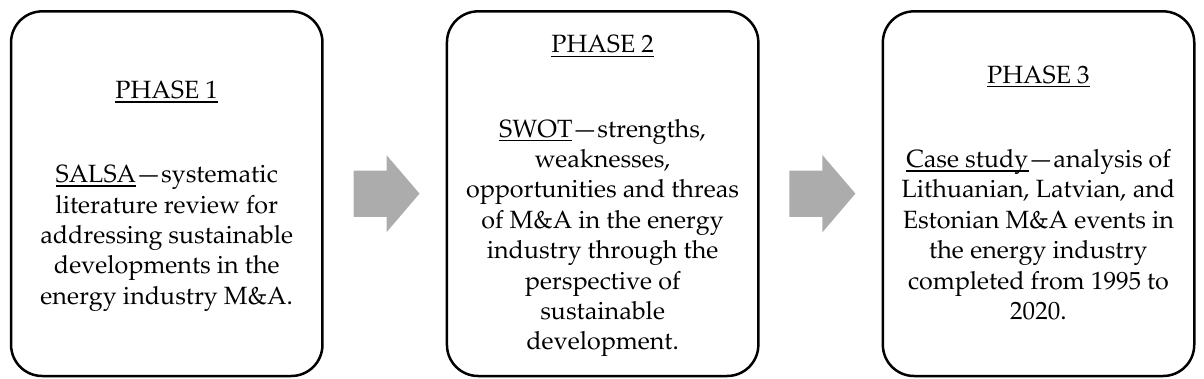
Figure 2. Methodological approach of the research. Source: created by authors.